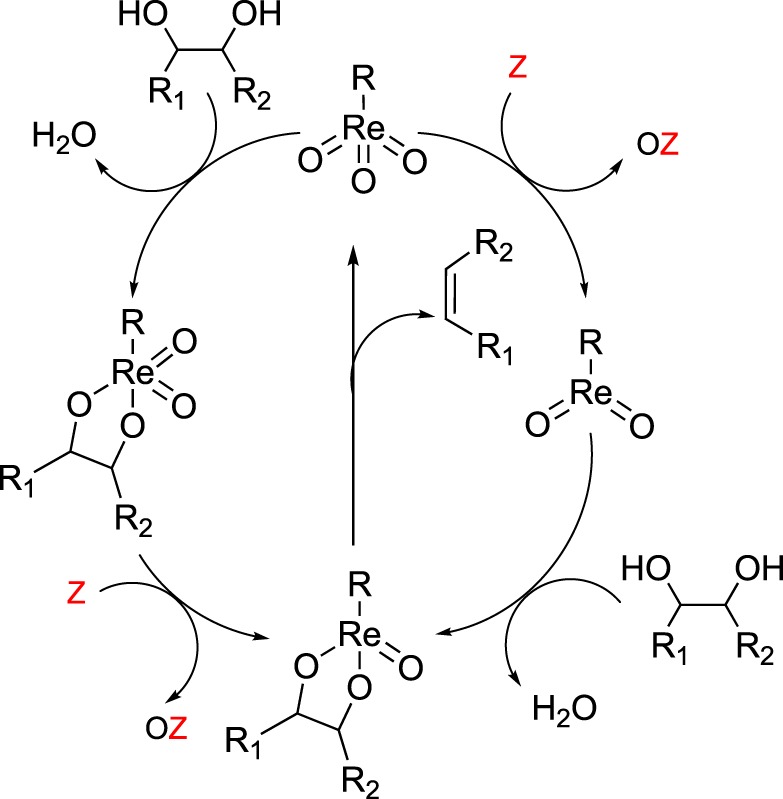
Possible DODH reaction mechanisms of RReO3 exploiting reduction by oxo-abstraction.